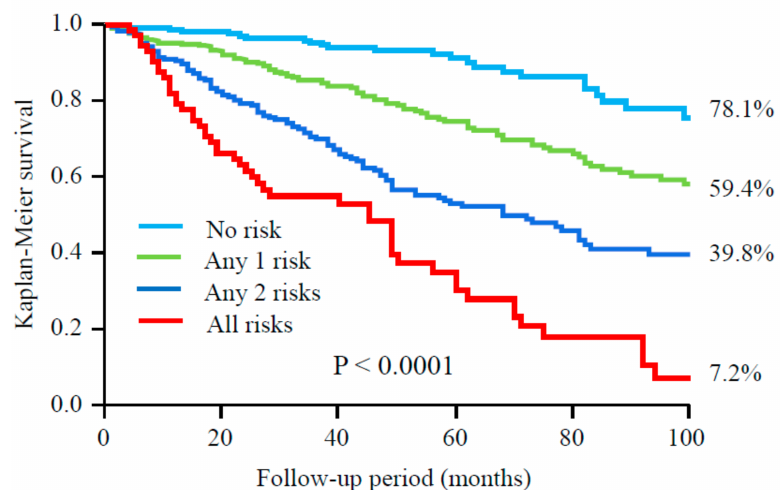
Figure 2. All-cause survival among groups according to number of risk factors, abnormal ABI, GNRI, and CRP. Table 4. Predictive value of abnormal ABI (<0.9 or >1.4), declined GNRI and elevated CRP for mortality due to cardiovascular disease (CVD) and all-cause